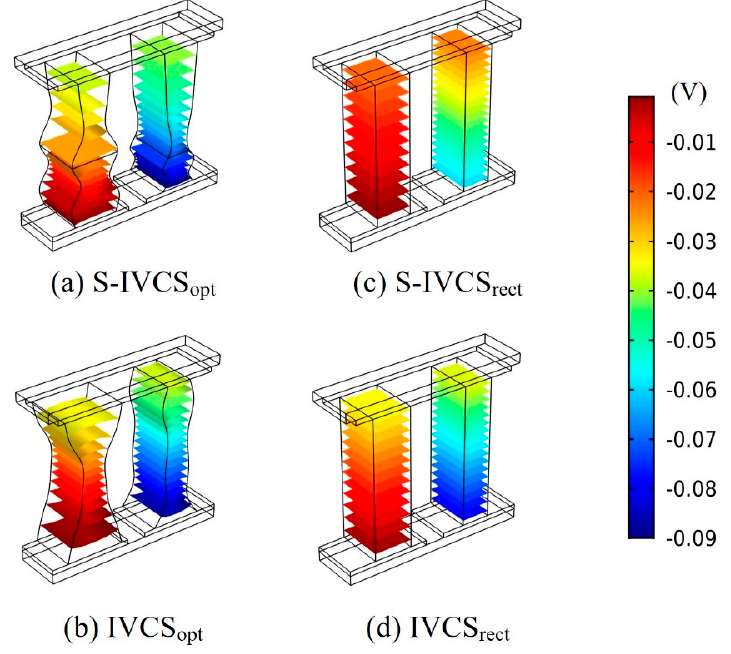
Figure 15. Electric potential contour comparison between the four designs.